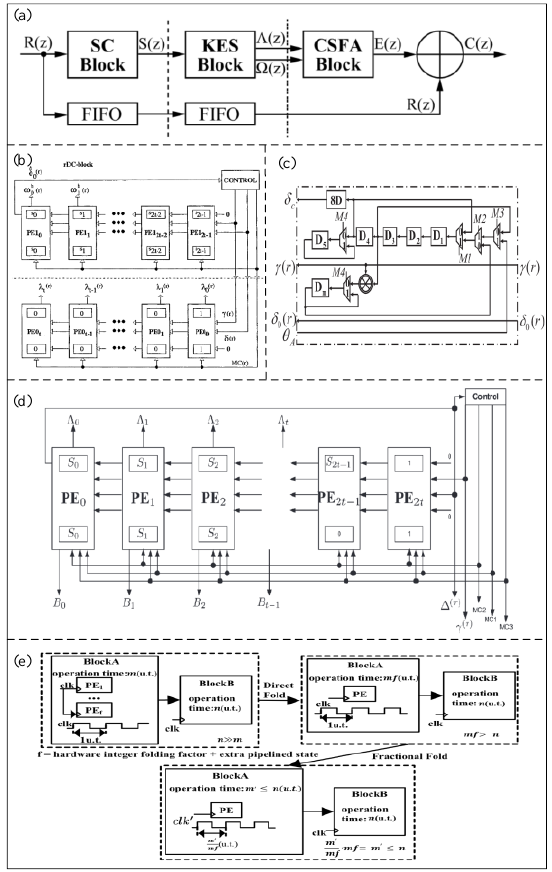
Figure 11. ( a ) Block diagram of RS decoder. (Reprinted from [75], Copyright 2017, with permission from IEEE). ( b ) The systolic RiBM architecture. (Reprinted from [73], Copyright 2001, with permission from IEEE). ( c ) The folded compensated simplified circuit diagram. (Reprinted from [76], Copyright 2019, with permission from IEEE). ( d ) EPIBM block diagram. (Reprinted from [77], Copyright 2015, with permission from IEEE). ( e ) The process of fractional folding. (Reprinted from [79], Copyright 2021, with permission from IEEE).